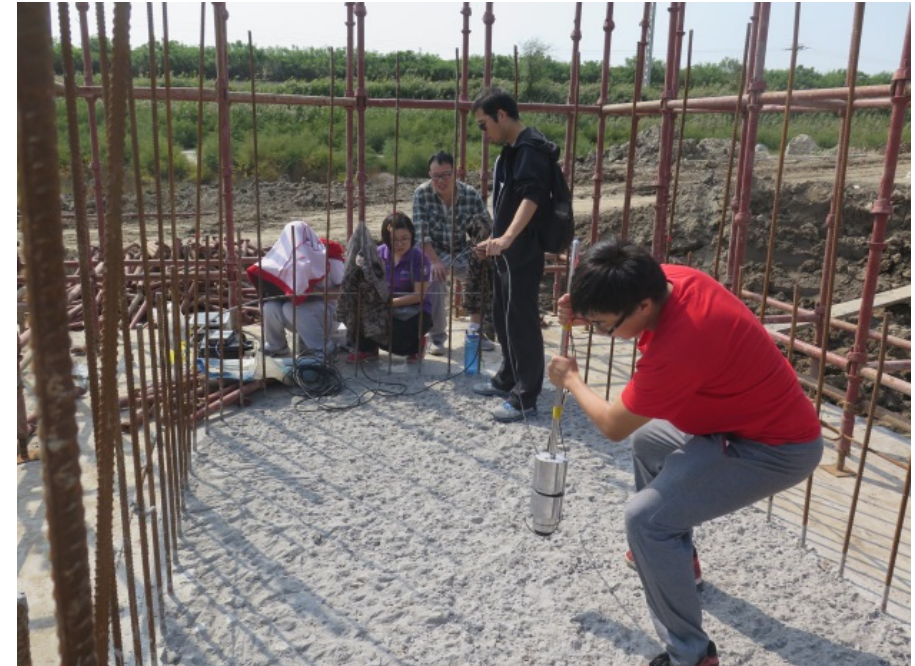
Figure 9. Knocking the cap surface with the hammer.